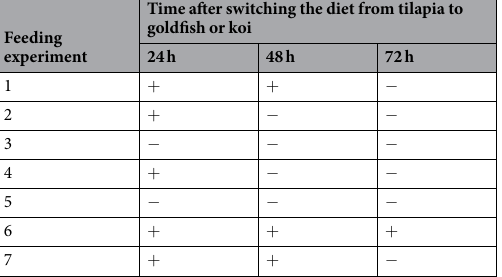
Table 2. The persistence of V . cholerae in the cormorants’ feces, days after their diets were switched from tilapia to golden fish or koi. The results demonstrate that V . cholerae can survive in the cormorants’ digestive tract up to 72 h after ingestion of tilapia (fish colonized by V . cholerae ).